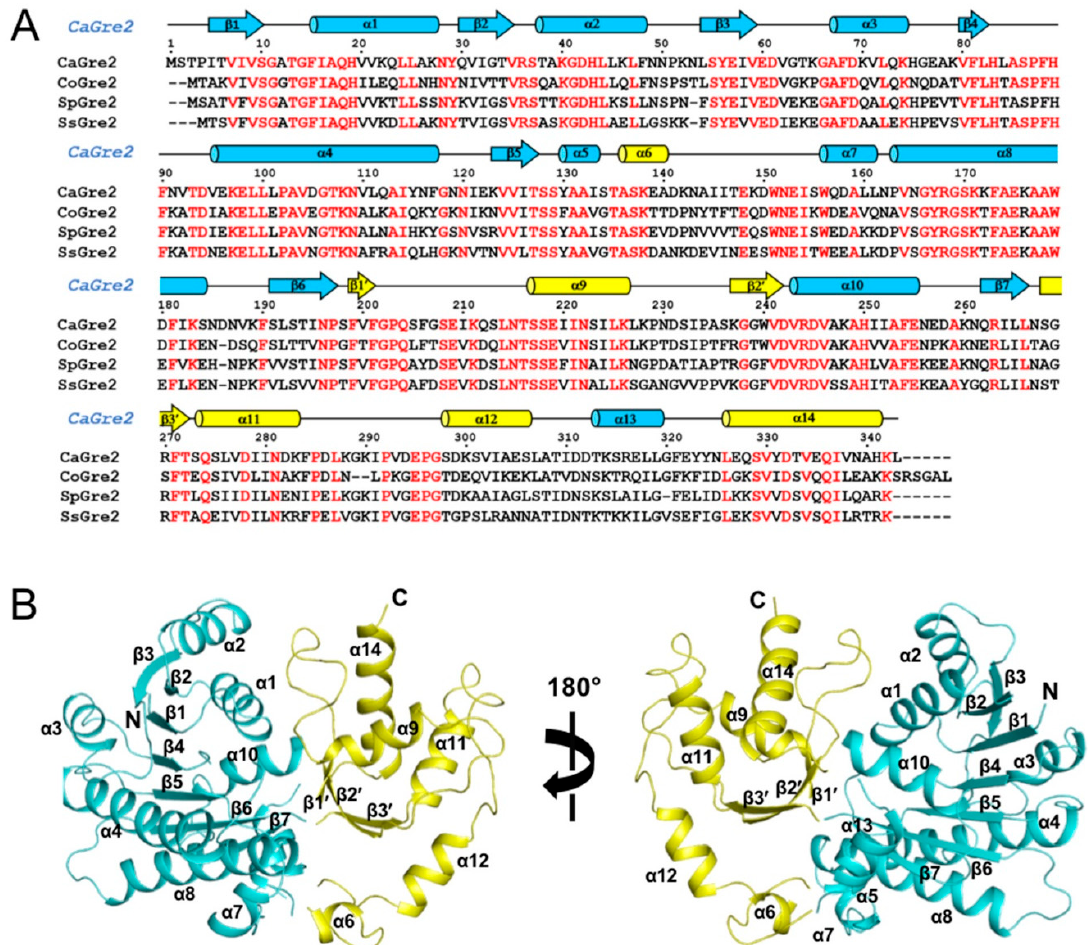
Figure 1. Overall structure of NADPH-dependent methylglyoxal reductase Gre2 from Candida albicans . ( A ) Multiple sequence alignment of Ca Gre2 (KGQ86193.1), Co Gre2 (XP_003870607.1), Sp Gre2 (XP_007377476.1), and Ss Gre2 (XP_001384081.2). Secondary structural elements of Ca Gre2 are presented on the top and are colored corresponding to di ff erent domains, as shown in ( B ). Conserved residues are marked in red. ( B ) Schematic representation of the overall structure of Ca Gre2. ( C ) The right panel shows a view of 180 ◦ rotation along the Y-axis from the orientation shown in the left panel. The Ca Gre2 N-terminal domain is shown in cyan, and the C-terminal domain is shown in yellow.